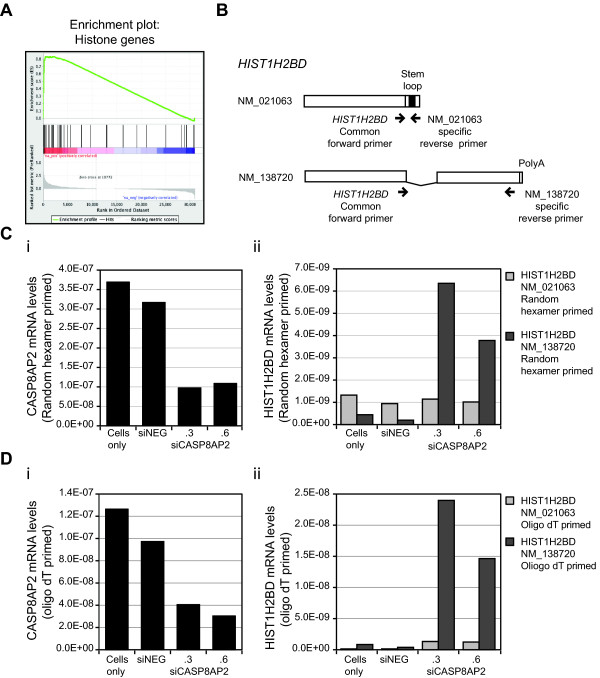
Loss of CASP8AP2/FLASH function induces changes in the expression of the replication dependent histone genes. (A) The CASP8AP2/FLASH RNAi signature was subjected to gene set enrichment analysis for 79 annotated human histone genes. A very high positive correlation was observed indicating a significant enrichment (Normalized enrichment score = 2.53; FDR q-value < 0.001) for deregulation of transcript levels of the human histone genes following silencing of CASP8AP2/FLASH. (B) Diagrammatic representation of the two annotated transcript variants of HIST1H2BD and the relative positions of PCR primers used in this study. The primers for the HIST1H2BD variant, NM_138720, were designed to flank a known splice site within this transcript so is its expression could be assessed by qRT-PCR without the risk of amplifying genomic DNA. (C) RT-PCR quantification of changes in (i) CASP8AP2/FLASH and (ii) HIST1H2BD expression using cDNA generated using random hexamer priming. (D) RT-PCR quantification of changes in CASP8AP2/FLASH and HIST1H2BD expression following silencing of CASP8AP2/FLASH. RNA was harvested 72 hours after silencing of CASP8AP2/FLASH and cDNA generated using either (i) random hexamers or (ii) oligo dT. Data is shown as the median of two independent cDNA syntheses and two independent PCR reactions per cDNA synthesis.